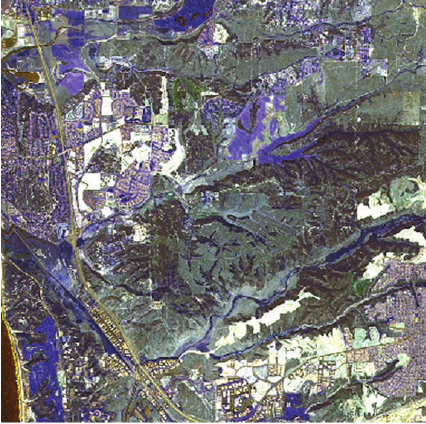
Figure 7: Image after fusion based on IHS